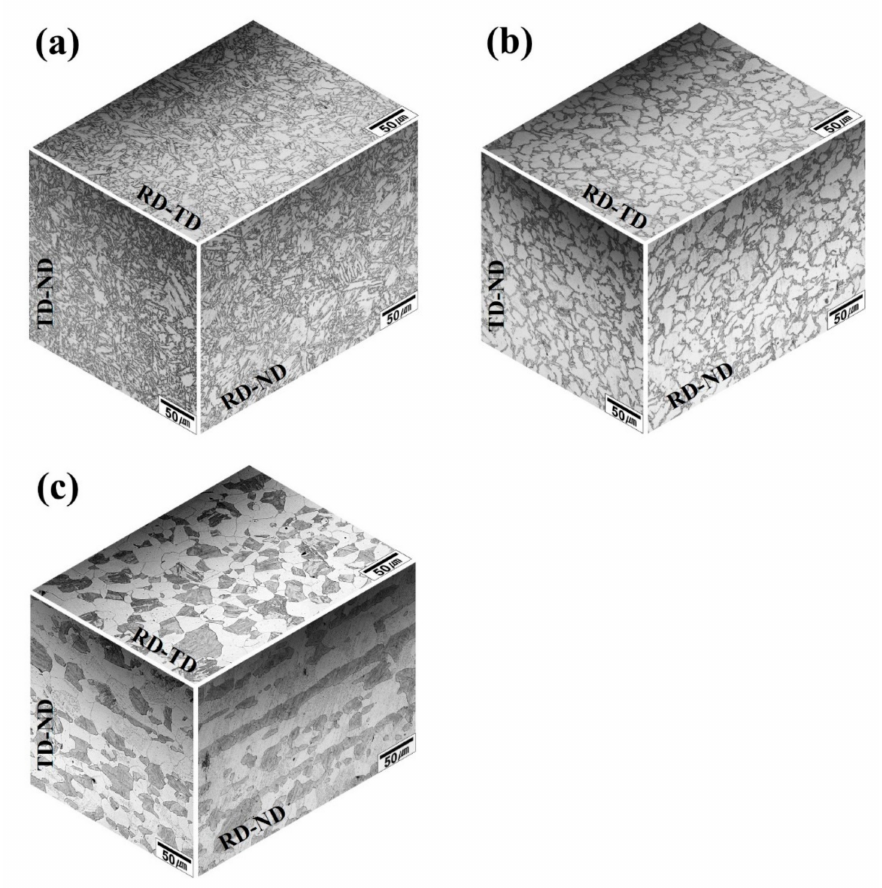
Figure 1. Optical microscope (OM) image of the investigated DP steels in three di ff erent planes. ( a ) WQ specimen, ( b ) AQ specimen, and ( c ) SQ